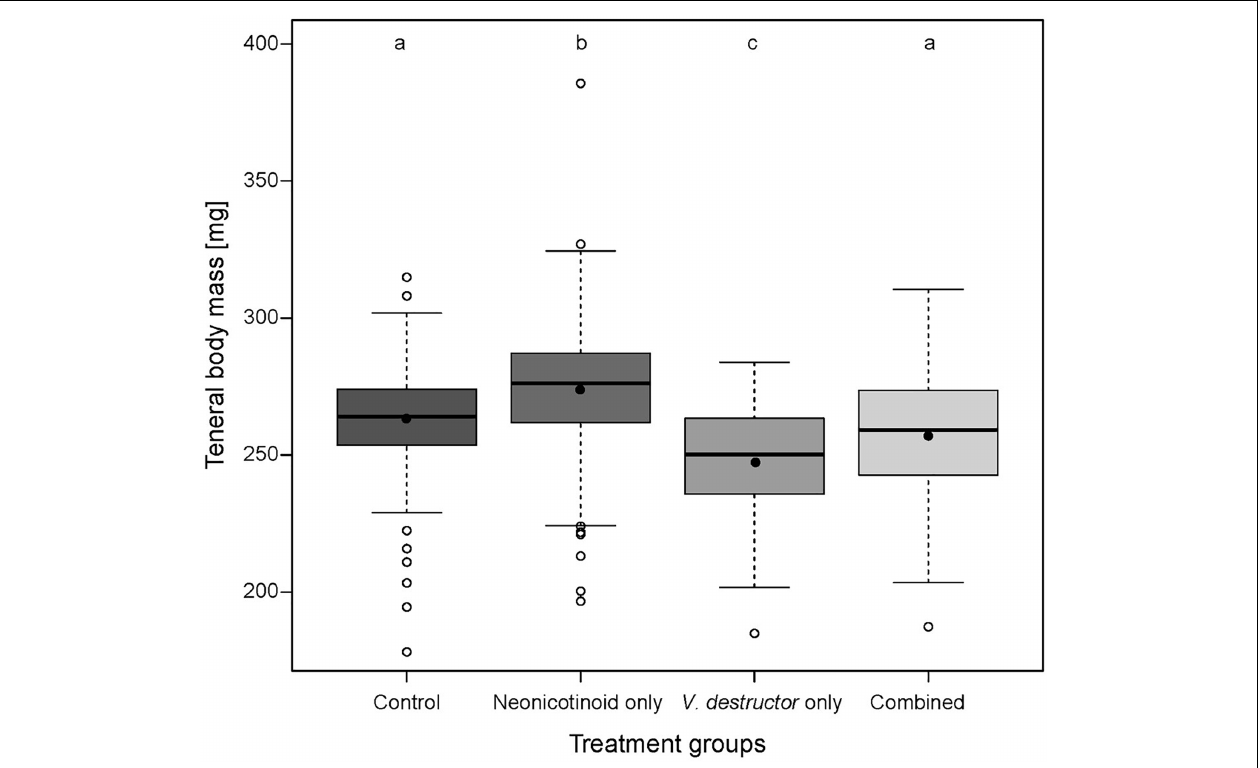
FIGURE 1 | Emergence body mass of experimental western honey bee ( Apis mellifera ) drones across four treatment groups: Control—drones without neonicotinoid exposure and without Varroa destructor parasitism ( n = 247), Neonicotinoid only—drones exposed to neonicotinoids during development but free from V. destructor parasitism ( n = 368), V. destructor only—drones infested by V. destructor during development, but not exposed to neonicotinoids ( n = 91), and Combined—drones exposed to both neonicotinoids and V. destructor during development ( n = 86). Boxplots show the inter-quartile range (box), the mean (black circles), the median (black line within box), data range (vertical black lines from box), and outliers (open circles). Different letters above boxplots indicate statistically significant differences ( p ≤ 0.05).